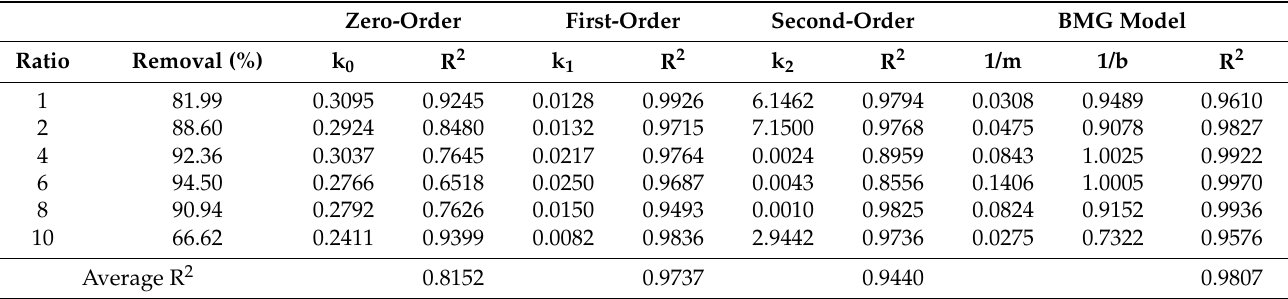
Table 4. Comparison of kinetic models at different molar ratios of Ca 2+ :Fe 2+ .